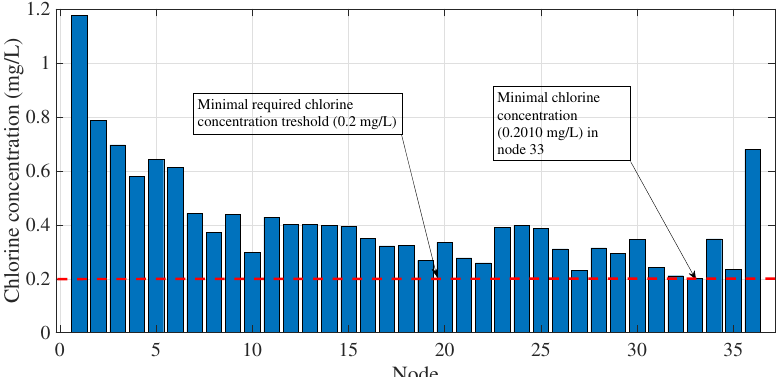
Figure 12. Minimal chlorine concentration at each node when s Q = 1.271229 mg/L and i Q = is 1.5 mg/L. In Figure 13 the evolution of the chlorine concentration at every measured node is illustrated. It is shown how during the simulated 55 h chlorine concentration remains always within the established limits of 0.2 and 1.5